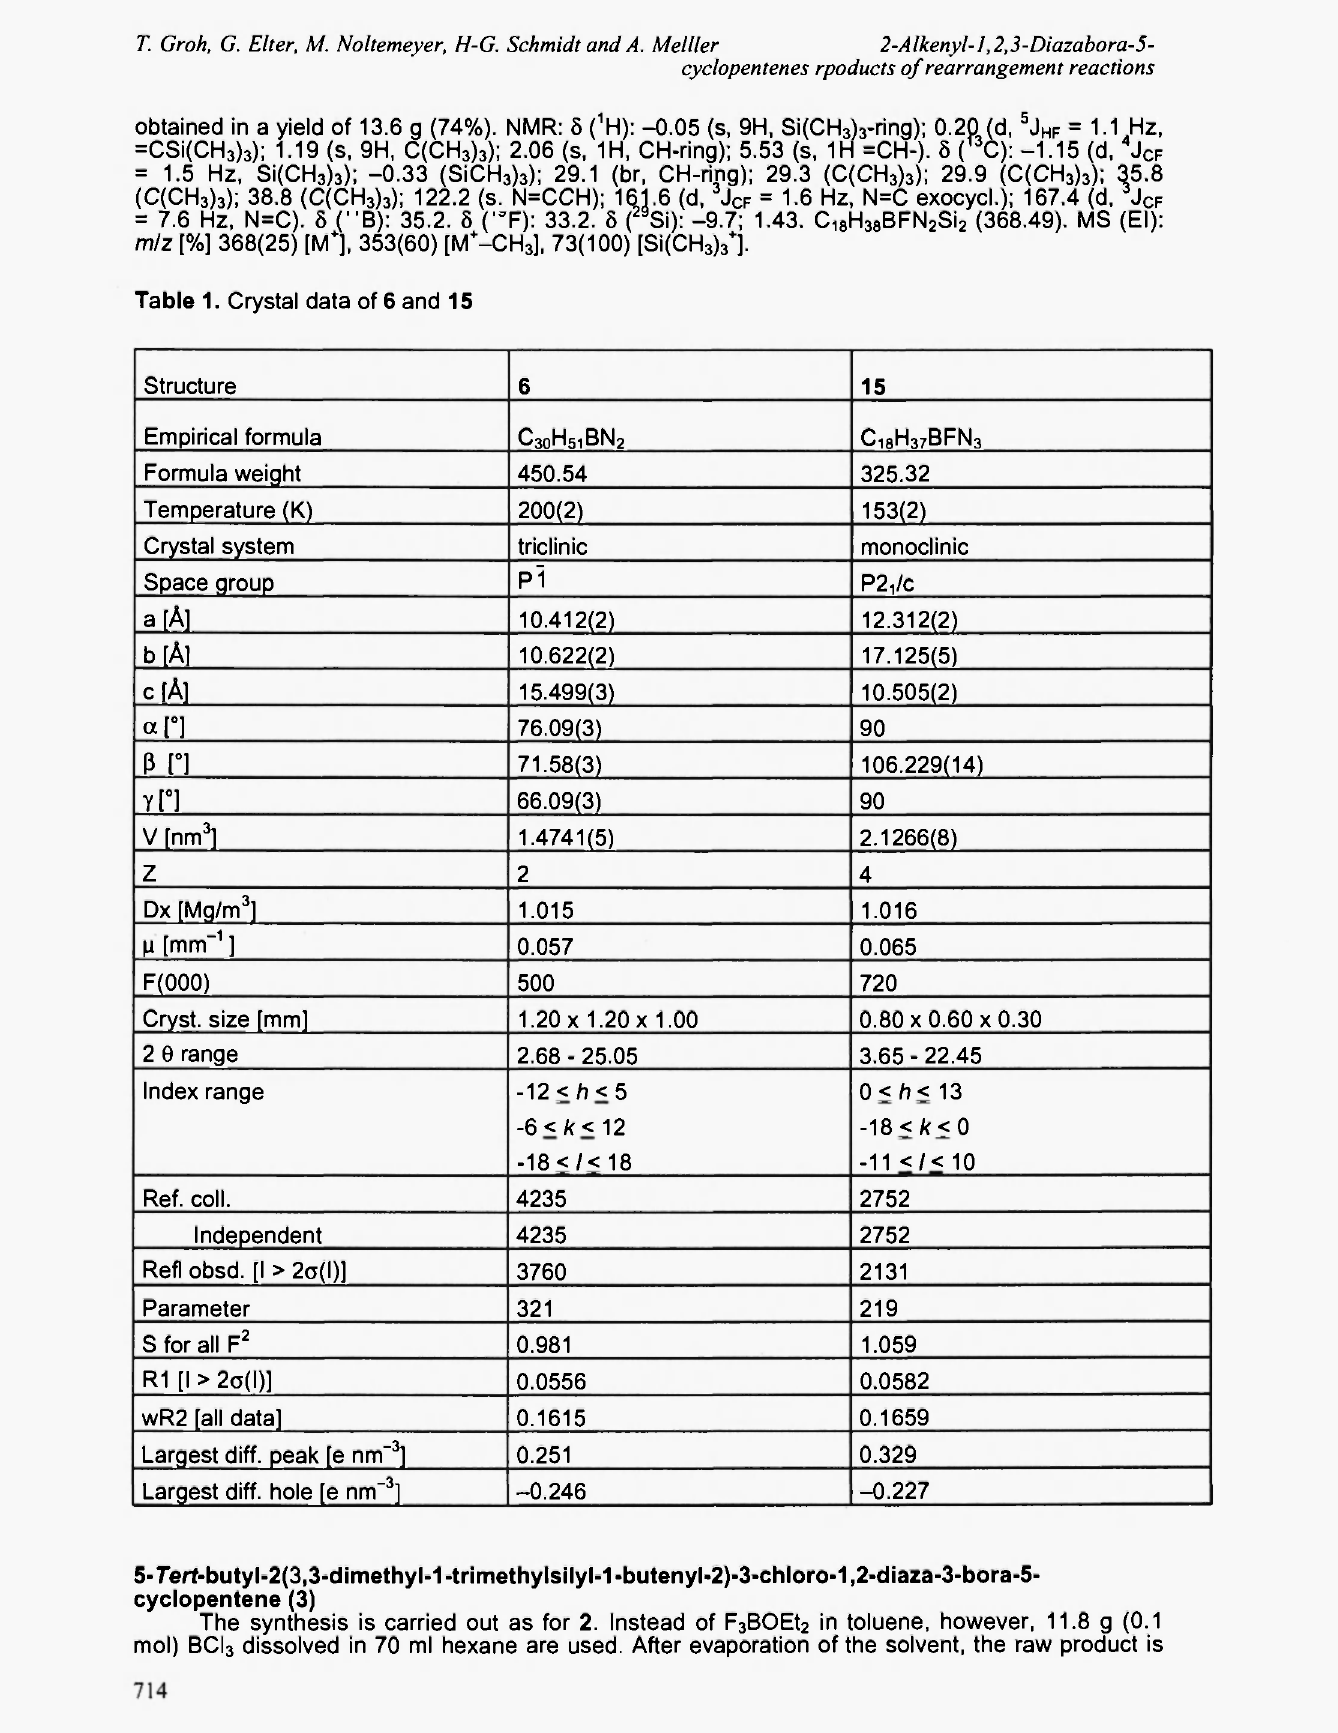
Table 1. Crystal data of 6 and